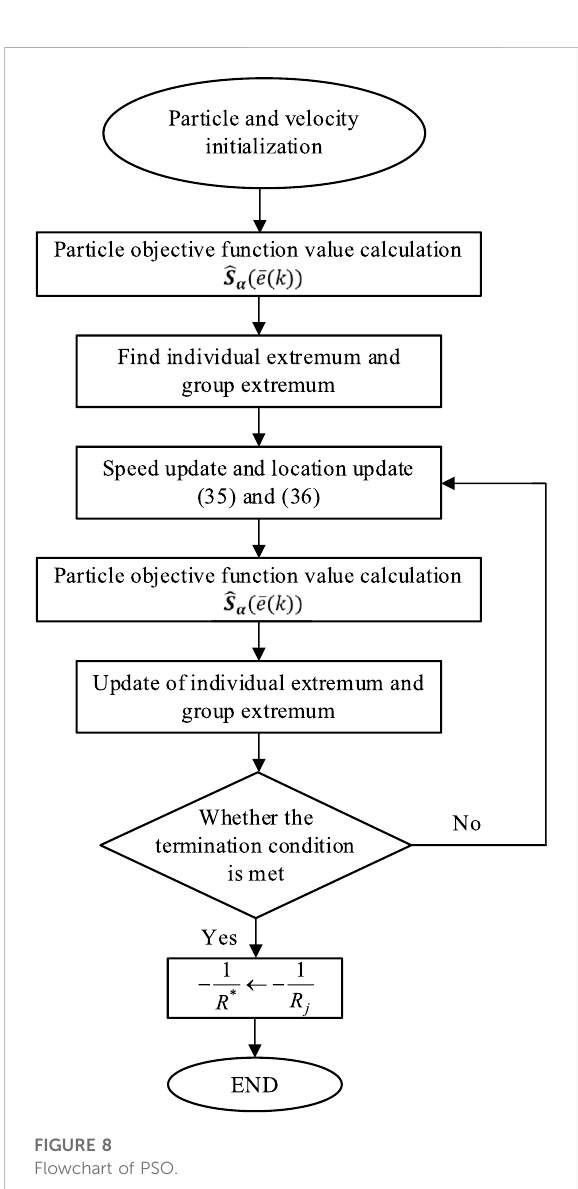
FIGURE 8 Flowchart of